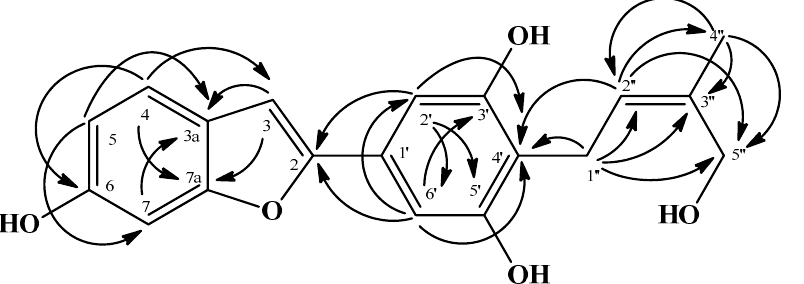
Figure 2. HMBC correlations (from H to C) of compound 1 .